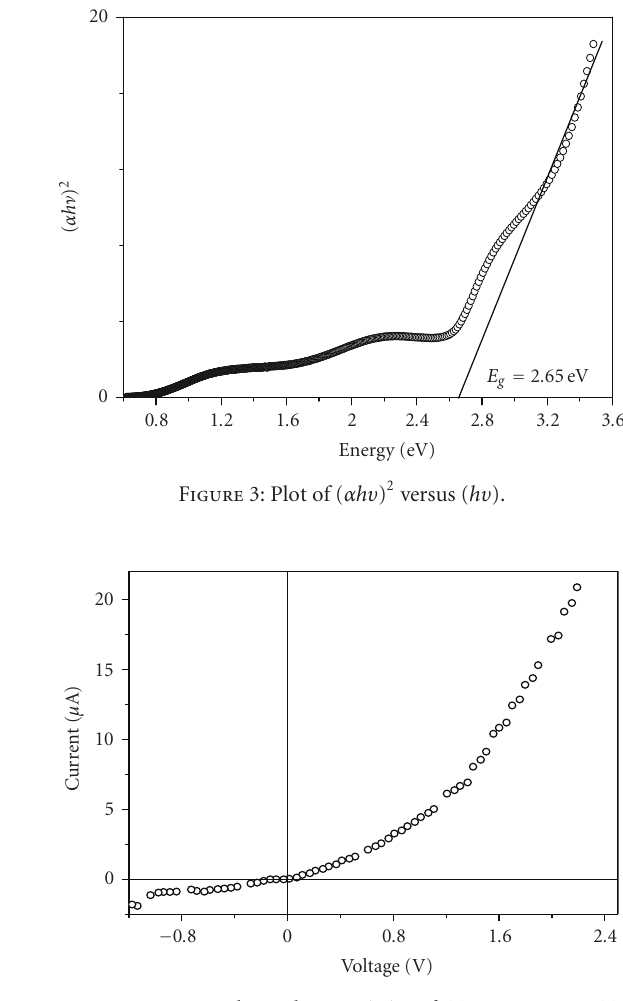
Figure 4: Current-voltage characteristics of ITO/PANI-co-POT/Al